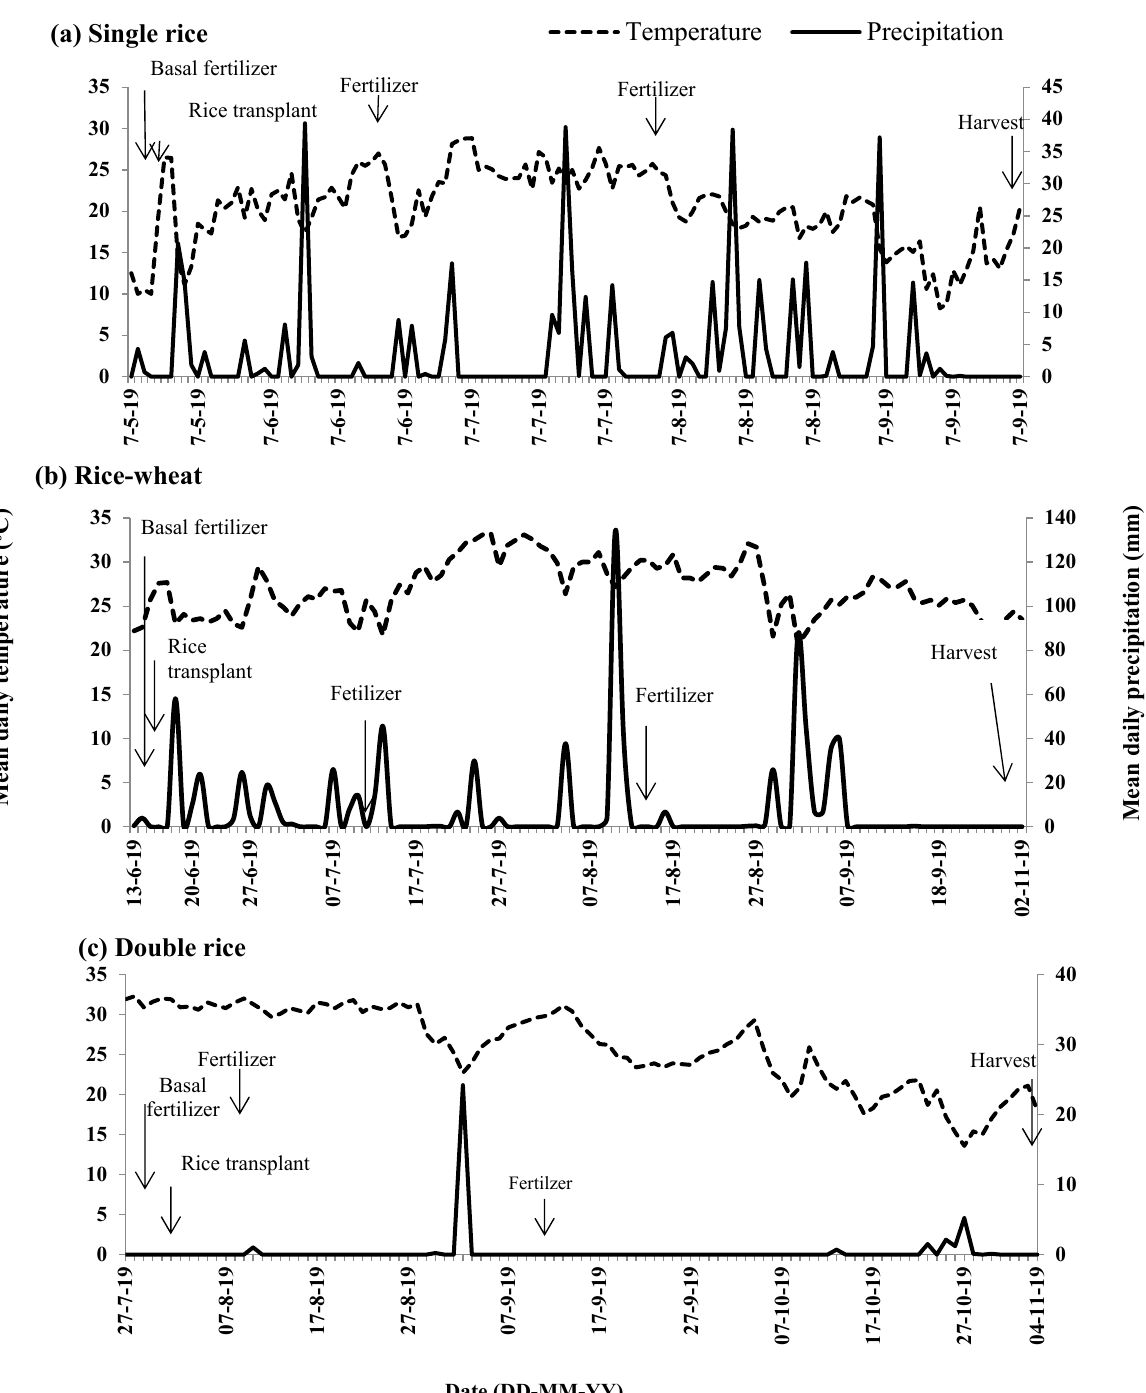
Figure 1. Daily average temperature, precipitation and management practices during the rice growing seasons in the three cropping systems.